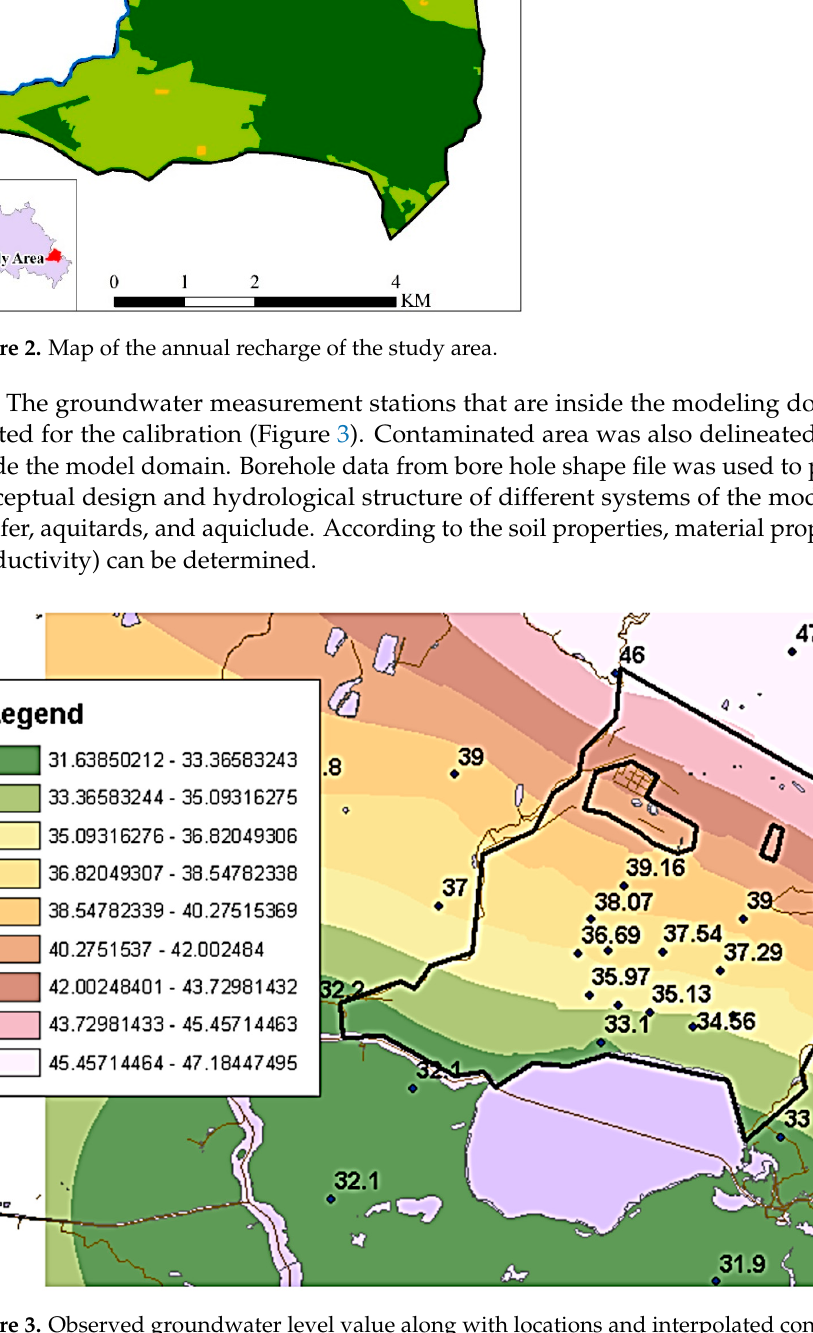
Figure 3. Observed groundwater level value along with locations and interpolated contour lines in the model domain.